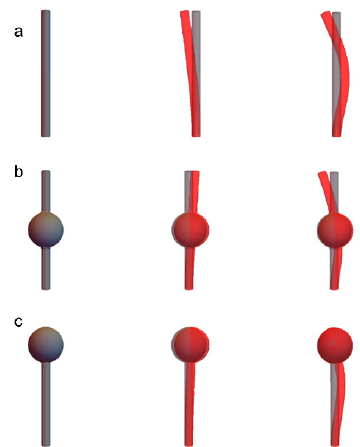
Figure 11. FEM simulation showing a perfect straight and uniform carbon nanotube ( a ), with a spherical mass at the center of the nanotubes body ( b ) and at the tip ( c ). The red fiber represents the nanotube under excitation. The first column is at null excitation, the second column refers to the first mode and the last column to the second mode. The simulation showed that an extra mass located at the center of the tube has a smaller impact on the resonance frequencies than a mass at the tip. Table 3. Finite elements simulation values of resonance frequencies at first and second mode for a CNT with no imperfections, with a mass in the middle of the body and with a mass at the tip. The percentage values are compared to the frequencies of a CNT with no extra